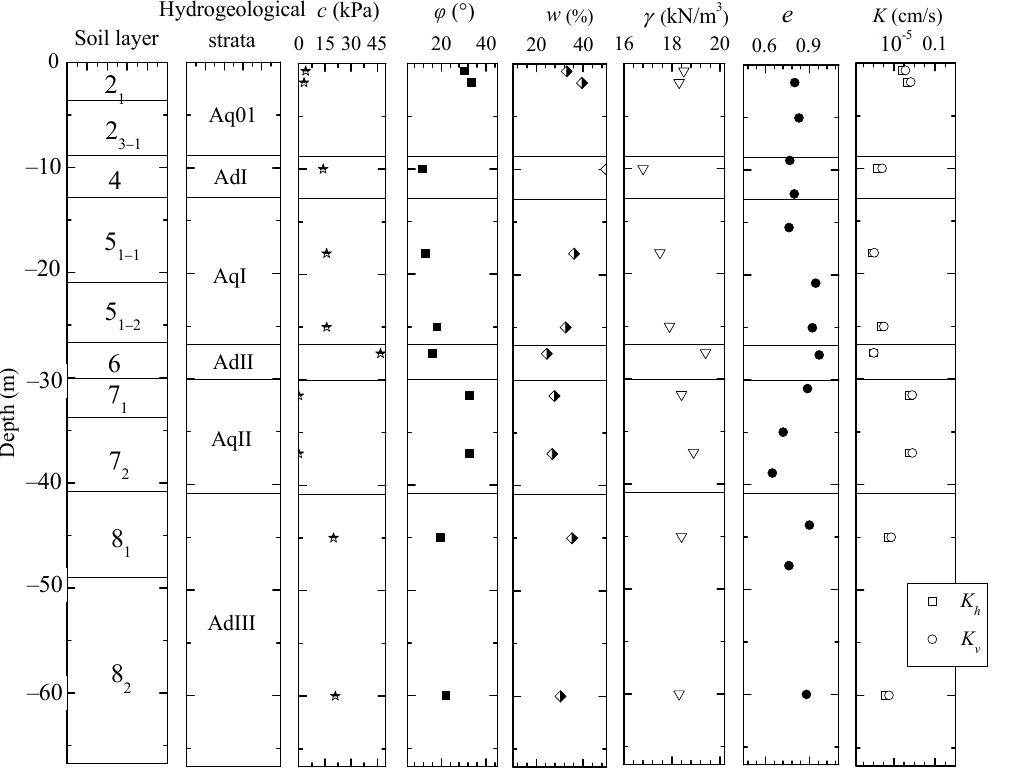
Figure 2. Soil profile and properties of soil layers.